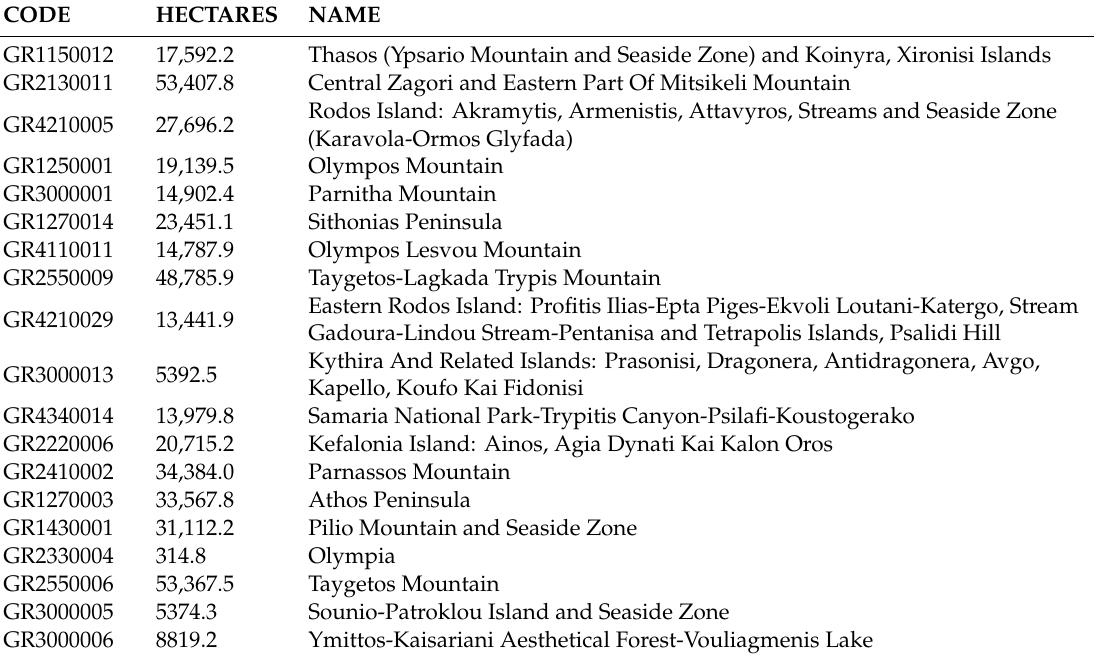
Table 1. Catalogue of the selected Natura 2000